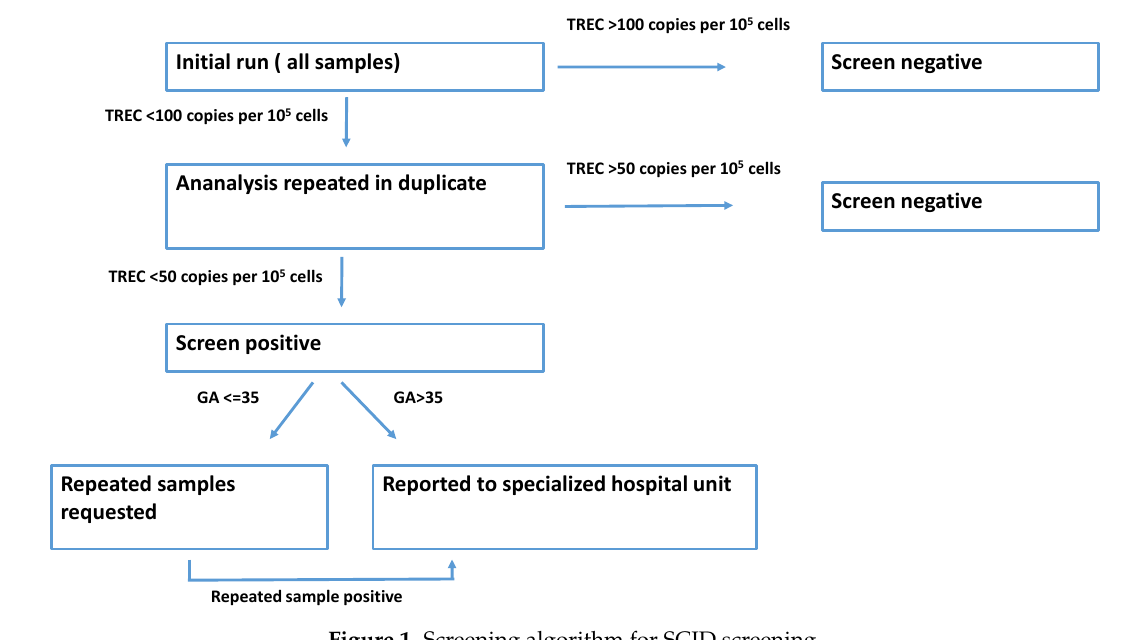
Figure 1. Screening algorithm for SCID screening .